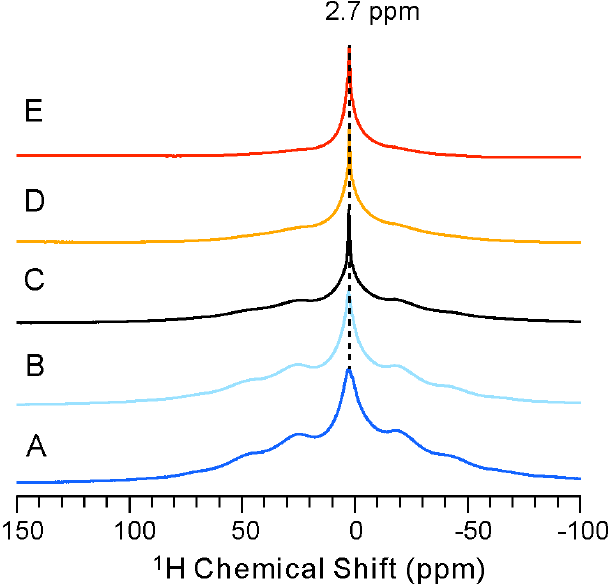
Figure 2. 1 H MAS NMR spectra of NPBA at five different temperatures: ( A ) 298 K; ( B ) 318 K; ( C ) 333 K; ( D ) 353 K and ( E ) 363